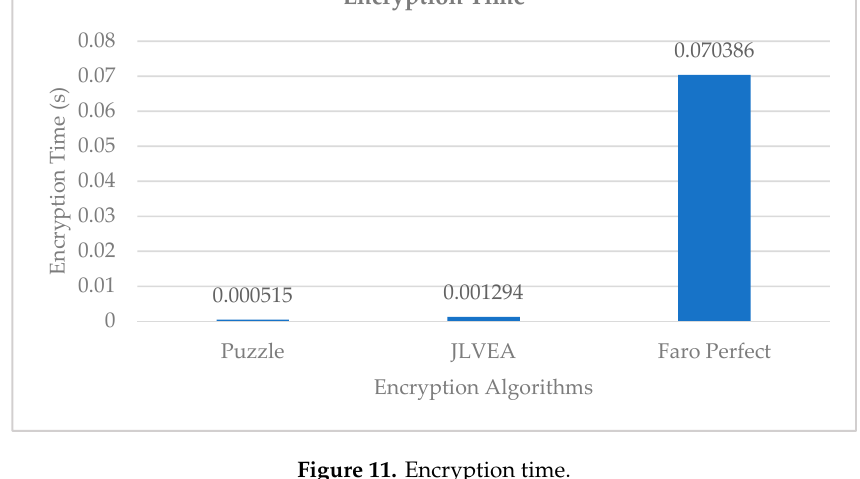
Figure 11. Encryption time. Sensors 2020 , 20 , x FOR PEER REVIEW